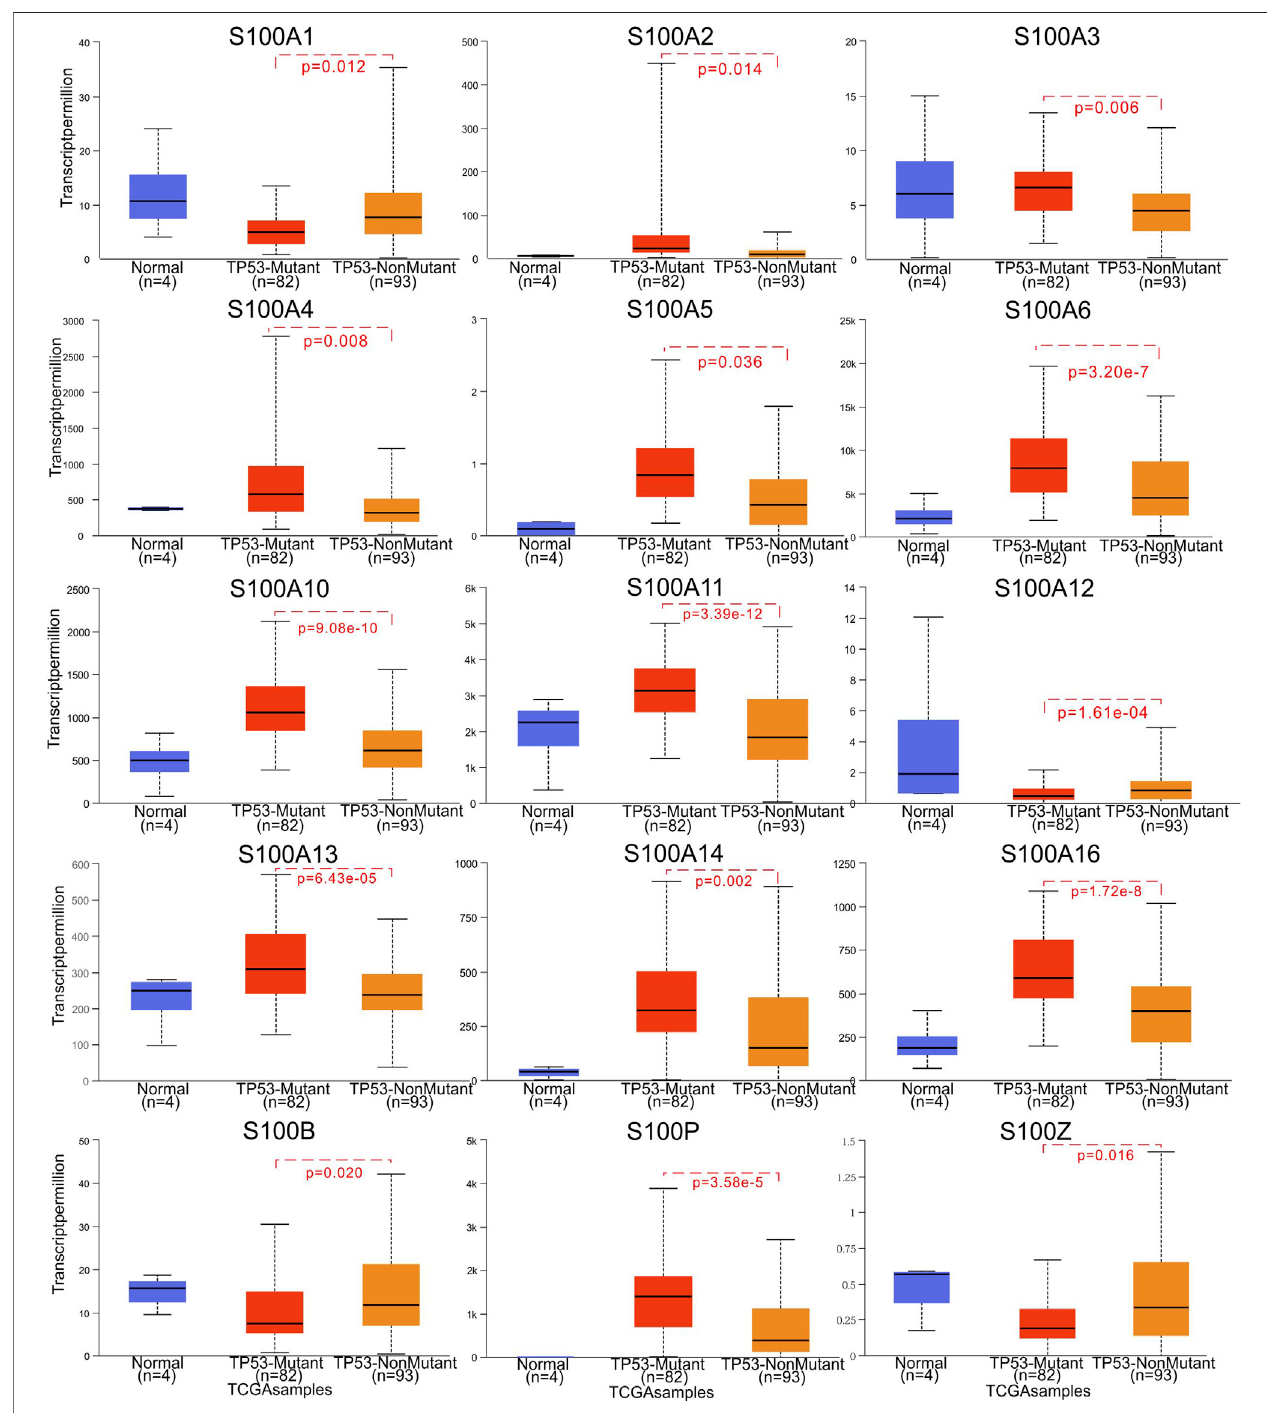
FIGURE5| CorrelationbetweenS100smRNAexpressionandTP53mutationinPAAD(UALCAN).Thesigni fi canceofdifferencebetweenTP53-mutantandTP53- nonmutant estimated by Student ’ s t -test with p value. The sample number N and the Student ’ s t -test p value are marked on the fi gure, respectively.